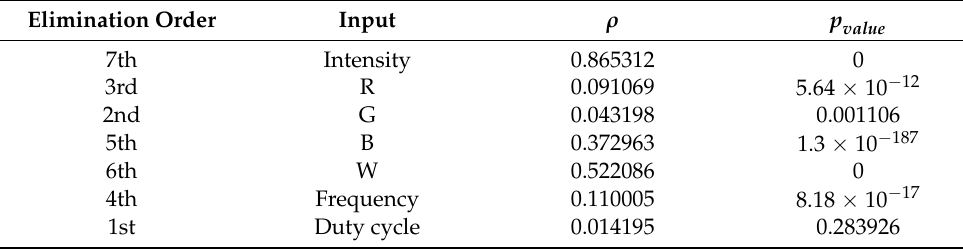
Table 3. ρ and p value correlation with energy consumption per input